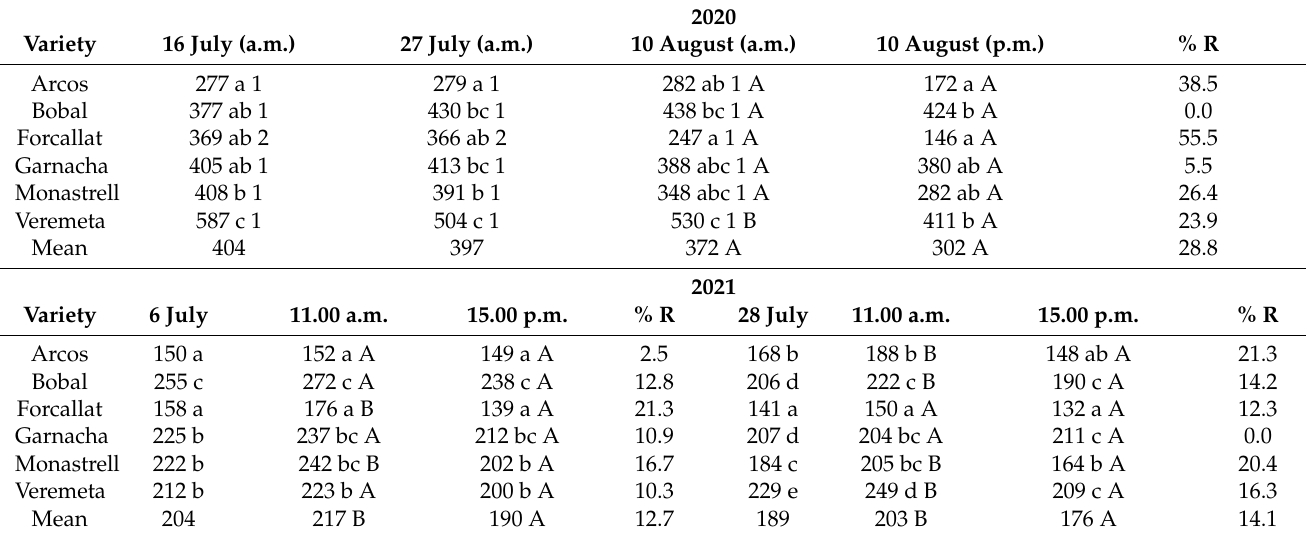
Table 3. Leaf stomatal conductance ( µ molH 2 Om − 2 s − 1 ) in plants of Arcos, Bobal, Forcallat, Garnacha, Monastrell, and Veremeta during the summers 2020 and